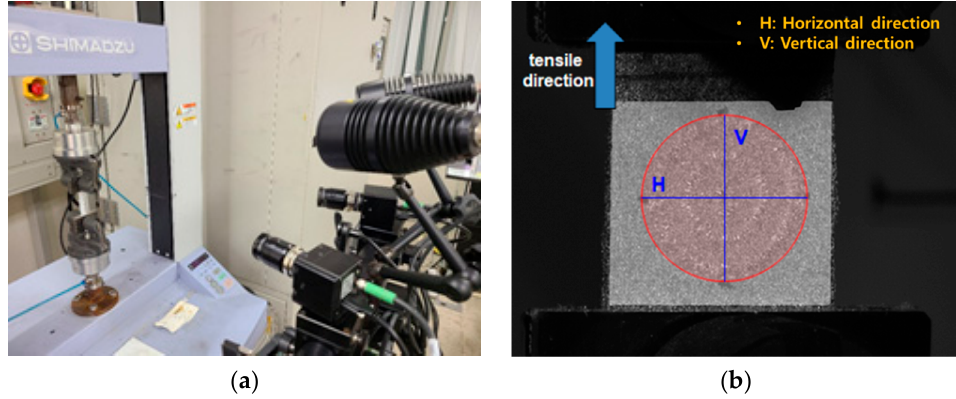
Figure 3. Measurement of the digital image correlation: ( a ) tensile tester and DIC system and ( b ) image of sample that positioned on tensile tester.